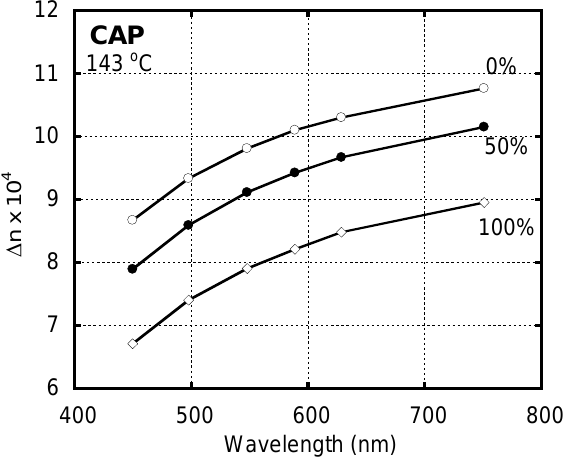
Figure 4. Wavelength dependence of orientation birefringence Δ n for CAP stretched at a draw ratio of 1.5 and exposed to 0% humidity (unfilled circles), 50% humidity (filled circles) and 100% humidity (unfilled diamonds). Drawing temperature is 143